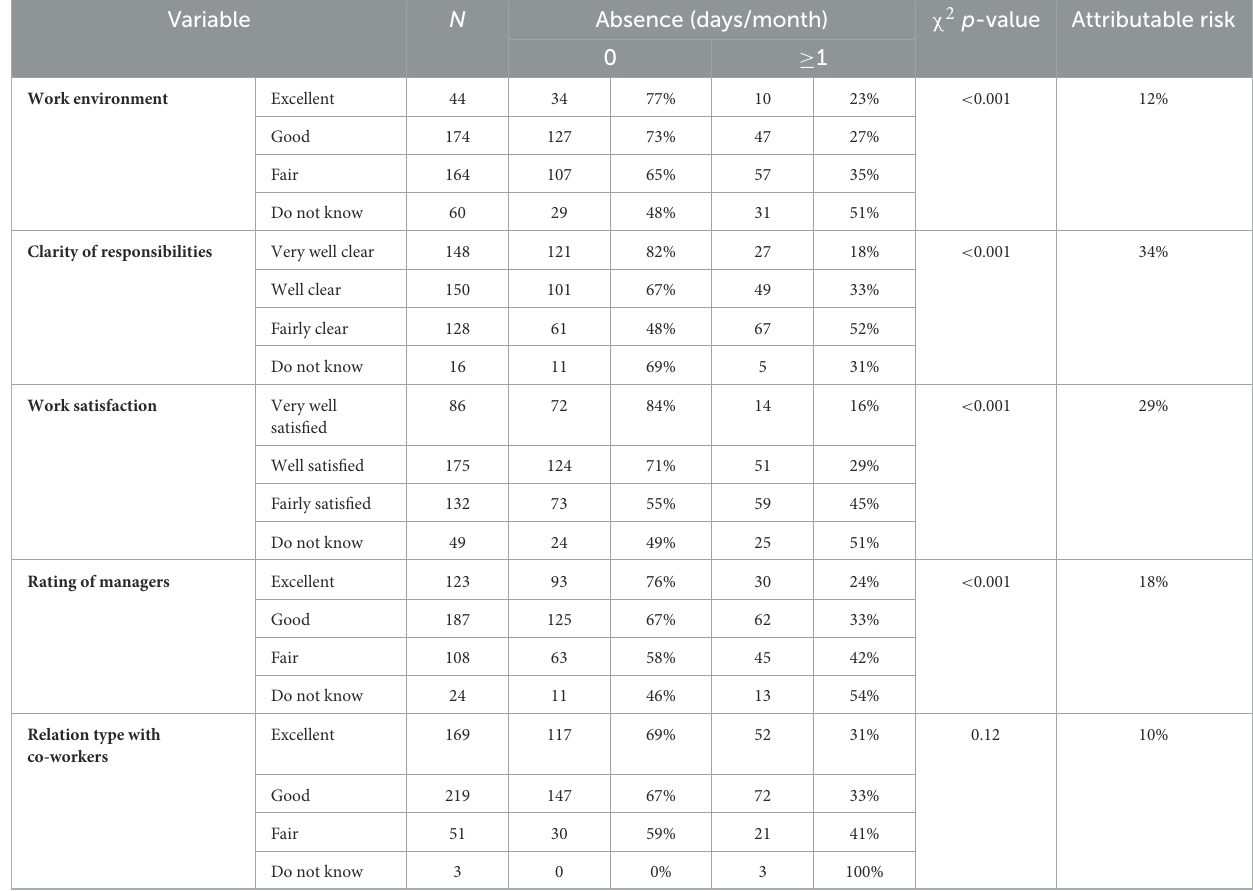
TABLE 3 Psychosocial factors associated with